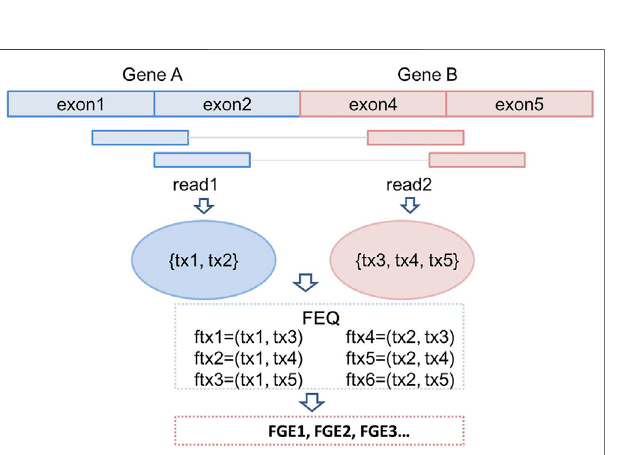
FIGURE 1 | Work fl ow of Fuseq-WES to detect fusion genes from whole-exome sequencing data.